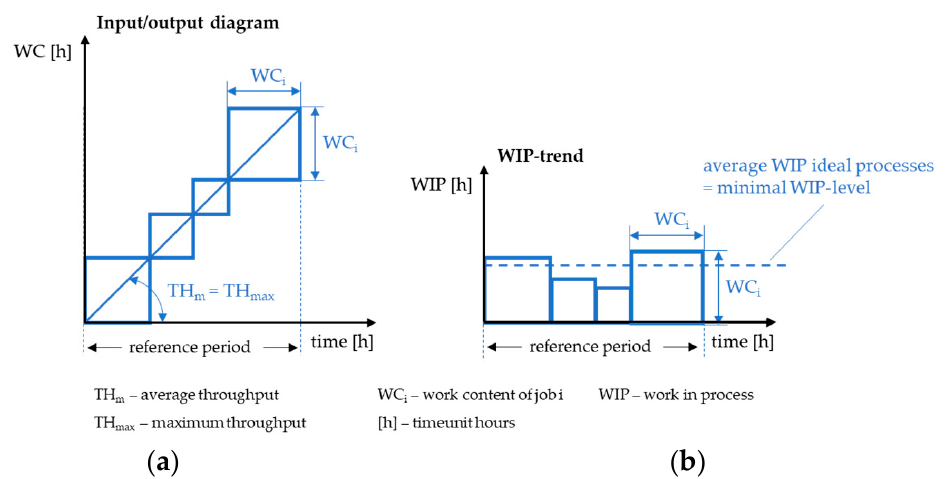
Figure 5. ( a ) Input/output diagram and ( b ) inventory development for an ideal process (based on this study by Nyhuis, P. and Wiendahl, H.-P.) [23] (p. 61).